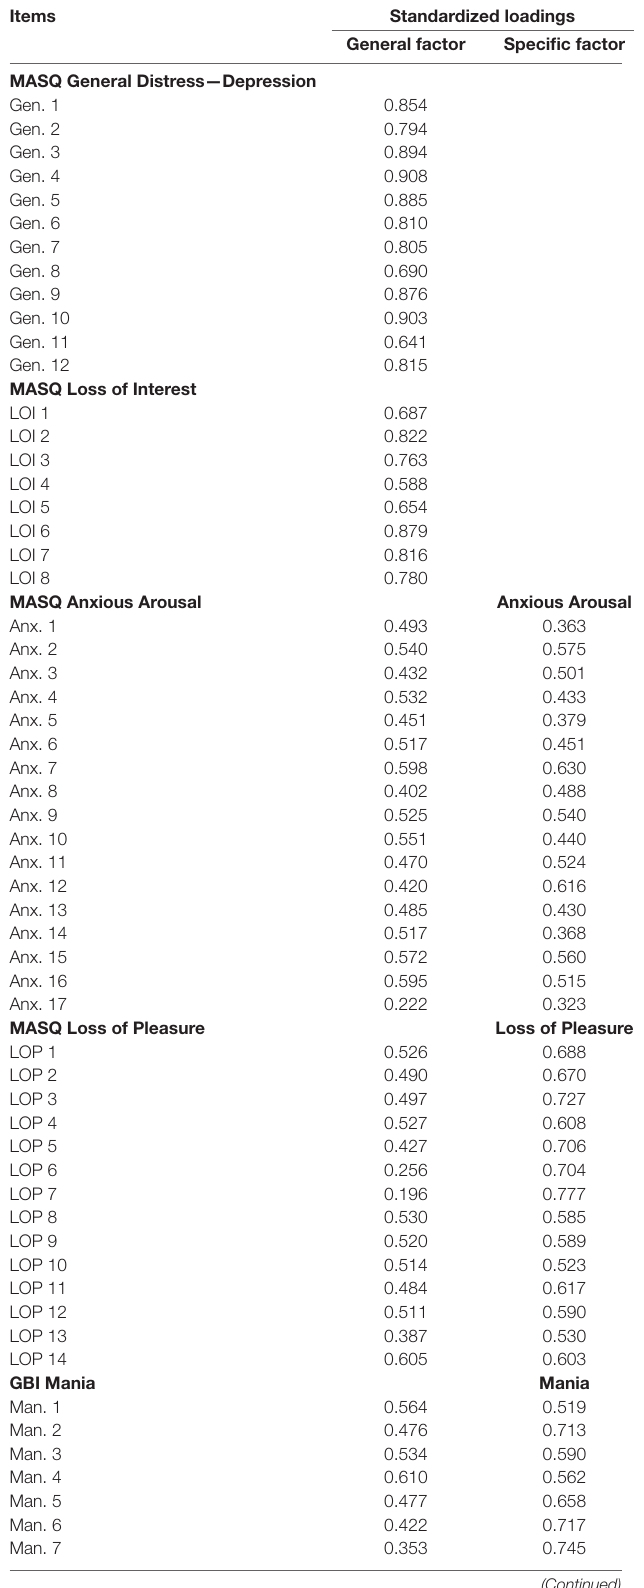
TABLE 6 | Item loadings in the confirmatory bifactor model.